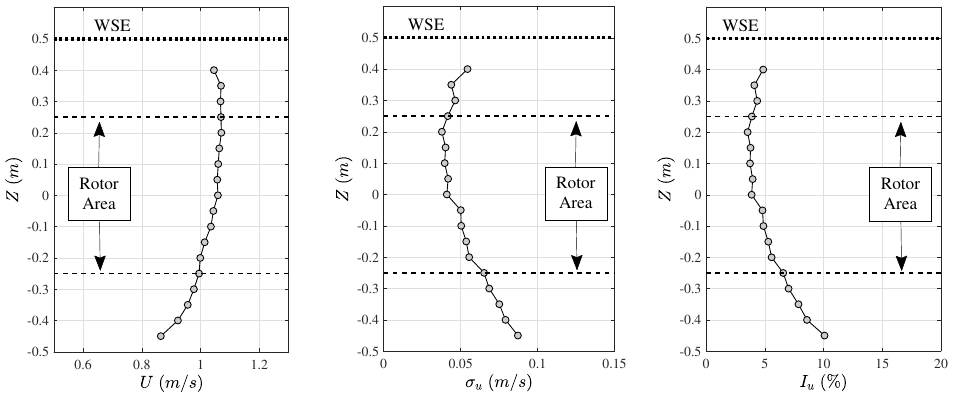
Figure 7. Inflow vertical profile characteristics in the center of the channel at 3 d T upstream of RM1: mean streamwise velocity, ¯ u (left), streamwise velocity root-mean squared, σ u = and streamwise turbulence intensity, I u (right). Area between dashed lines − 0.25 m ≤ Z ≤ 0.25 m indicates RM1 rotor energy extraction plane. Mean water surface elevation (WSE) is indicated by dashed line at Z = 0.5 m. Turbine hub height, h hub , is located at z = 0